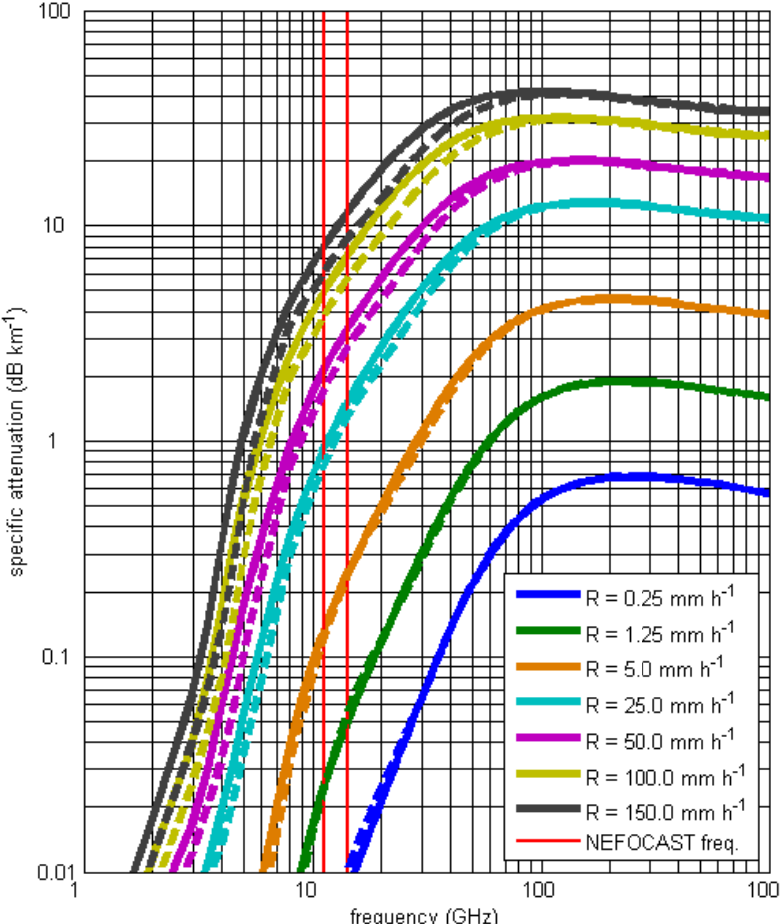
Figure 5. Specific attenuation in dB/km vs. carrier frequency in GHz (from recommendation ITU-R P.838-3 [29]), with the rain rate (mm/h) as the parameter. Solid lines and dashed lines refer to horizontal and vertical polarization, respectively.